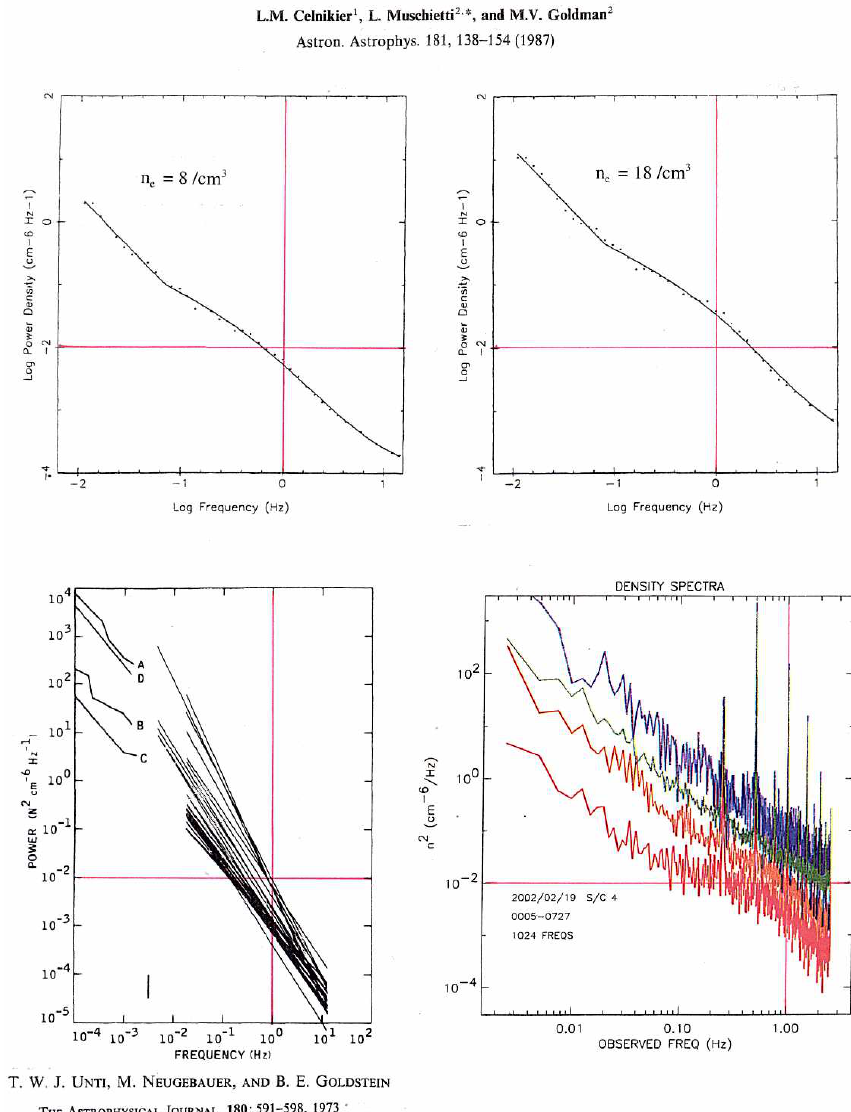
Fig. 5. Comparison with earlier density spectrum